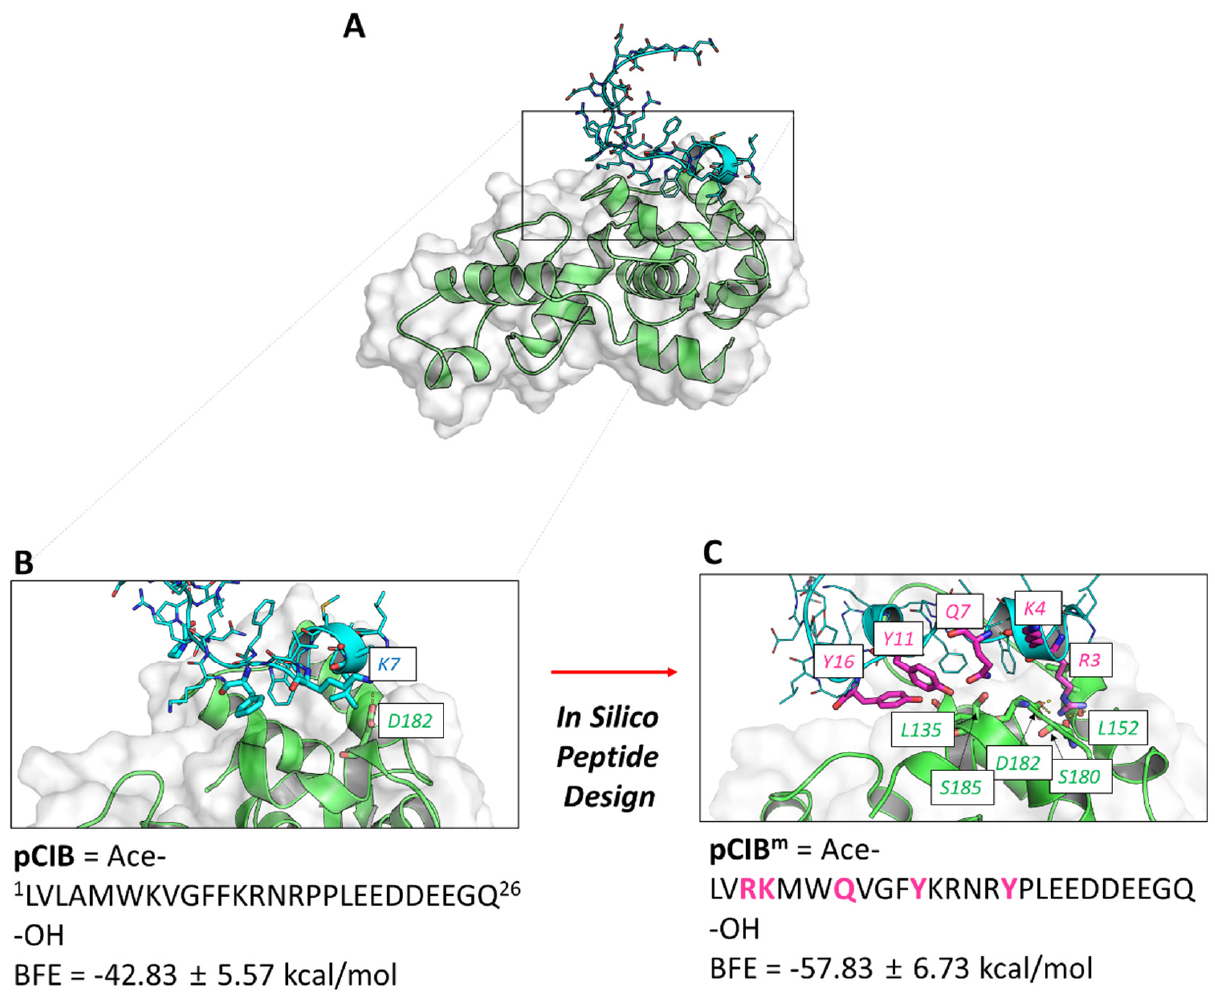
Figure 5. Molecular dynamics simulation of the pCIB–CIB1 complex formation. ( A ) Reported structure of CIB1 in complex with the pCIB peptide, mimicking part of the intracellular α IIb chain. ( B ) Calculated structure of the pCIB–CIB1 complex obtained by molecular dynamics simulation. ( C ) Structure of the modified pCIB m -CIB1 complex by molecular dynamics simulation. Color code: hydrogen bonds shown as yellow dashed lines; amino acid residues of the wildtype ( B ) and mutated ( C ) peptides are indicated in cyan and magenta, respectively; CIB1 residues are pictured in green; also indicated per peptide is the calculated binding free energy (BFE).